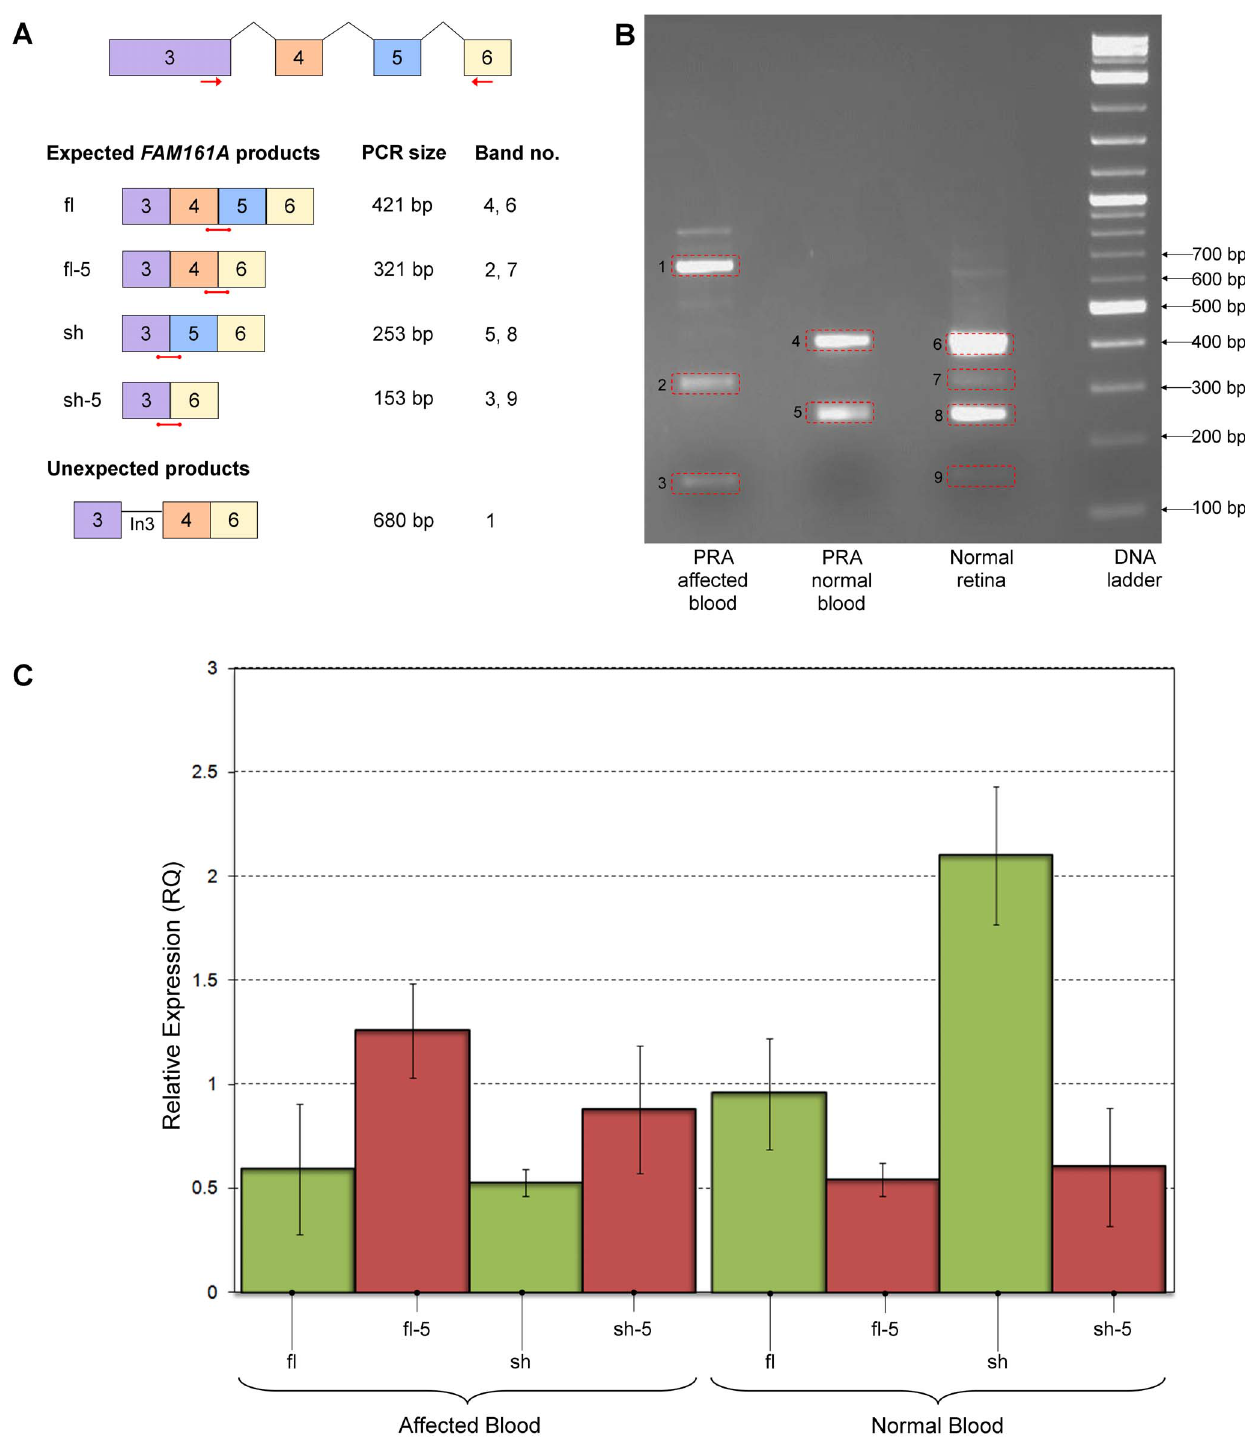
Figure 6. Comparison of FAM161A mRNA isoforms. PCR, electrophoresis and qRT-PCR to compare the FAM161A isoforms in blood from affected and unaffected dogs. A) Primers in exons 3 and 6 (red arrows) were used to amplify FAM161A isoforms created by alternative splicing of exons 4 and 5, resulting in four possible amplicons expected (fl, fl-5, sh, sh-5; sizes indicated). Red bars represent isoform-specific qPCR probes. B) Agarose gel electrophoresis of PCR amplicons. C) Relative expression of each target (wildtype targets in green and mutant targets in red), determined by qPCR. Error bars represent the standard deviation.